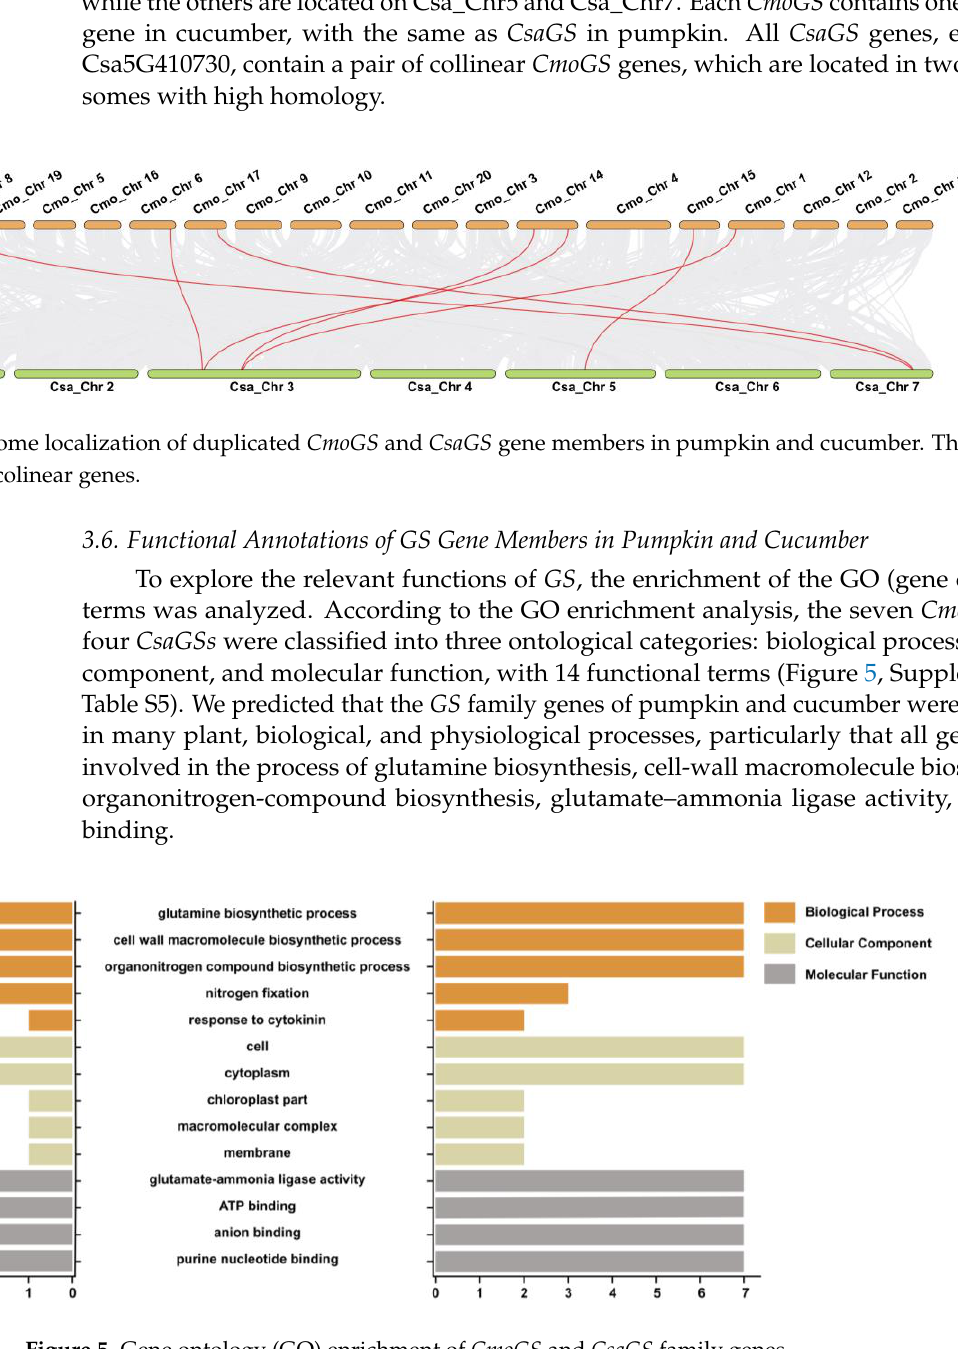
Figure 5. Gene ontology (GO) enrichment of CmoGS and CsaGS family genes.